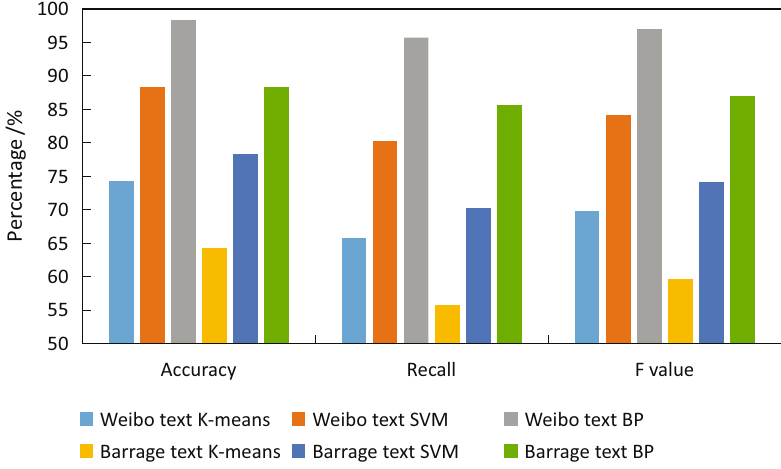
Figure 5: Recognition performance of three rumor evaluation models for Weibo texts and bullet screen